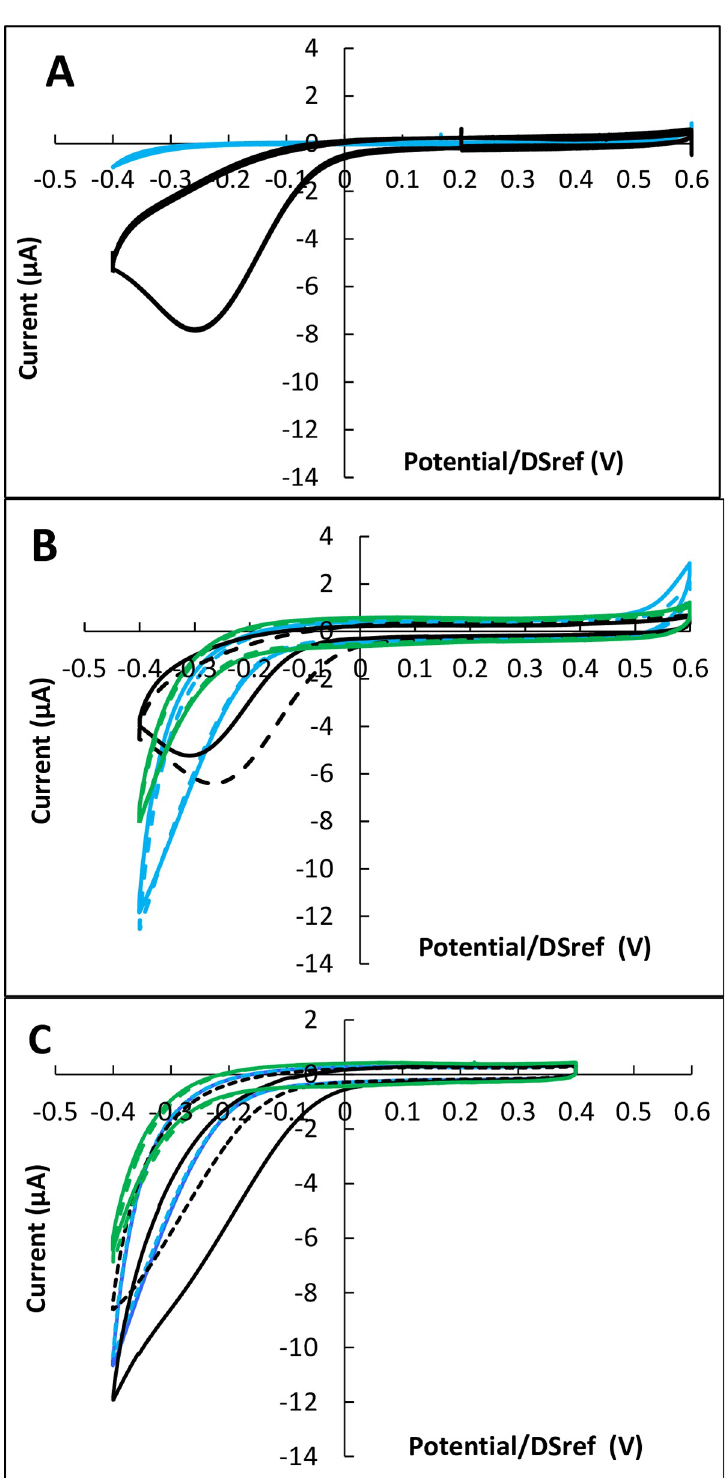
Fig 7. Cyclic voltammetry of MRC5 after 4 hours’ incubation. Inoculation with 200 000 cells; potential scan rate 10 mV.s -1 . A) carbon electrodes coated with poly-D-lysine; B) carbon electrodes coated with CNT and poly-D-lysine; C) carbon electrodes. Black: With cells; blue: Control without cells; green: Supernatant; in each case dotted lines are duplicates. Potentials are expressed vs. the DropSens pseudo-reference (DSref), values vs. SHE can be obtained by adding 0.290